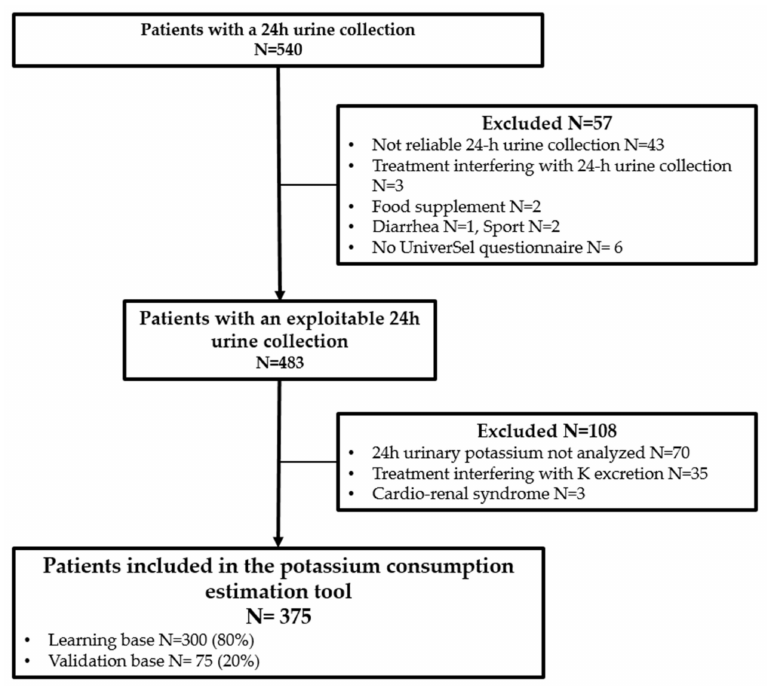
Figure 1. Flow chart of the UniverSel study